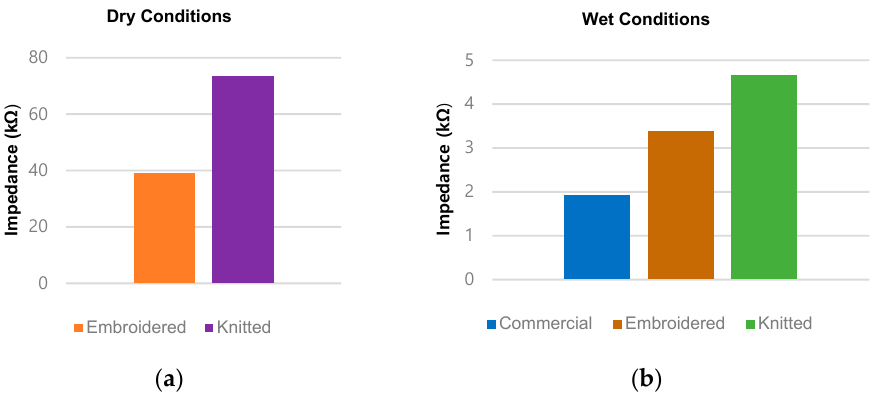
Figure 10. Experimental results for the skin-electrode impedance measurement. ( a ) Dry condition; ( b ) wet condition, in which the impedance of the embroidered electrode has 175% of that of the commercial electrode and that of the knitted electrode has 241% of that of the commercial electrode, respectively.